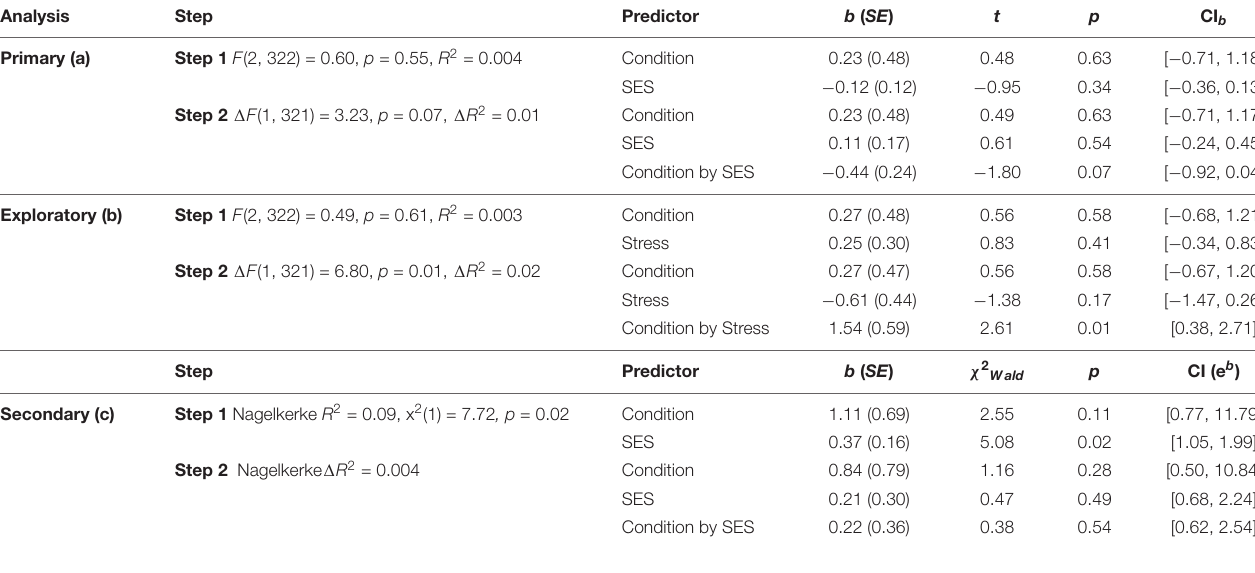
TABLE 2 | Multiple regression analyses predicting (a,b) smoking reduction and (c) smoking cessation. Analysis Step